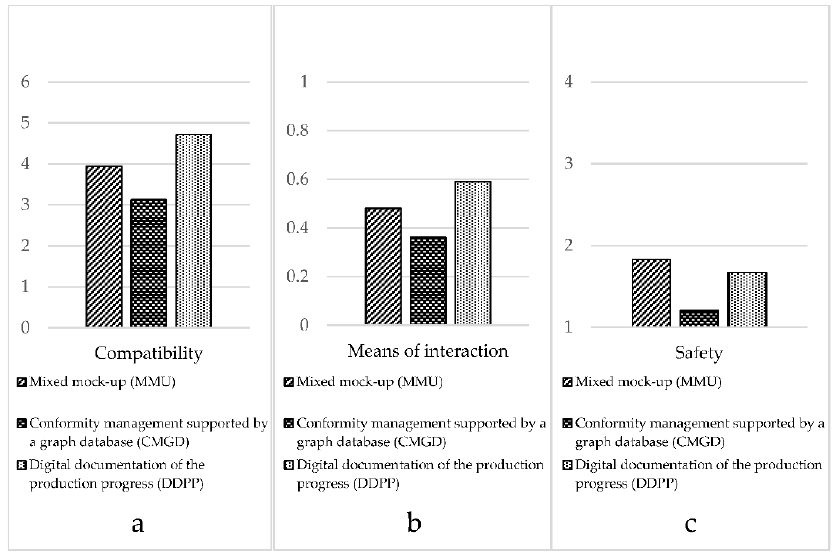
Figure 2. Means of the criteria ( a ) compatibility , ( b ) means of interaction and ( c ) safety on the technological dimension with statistically significant differences between the three